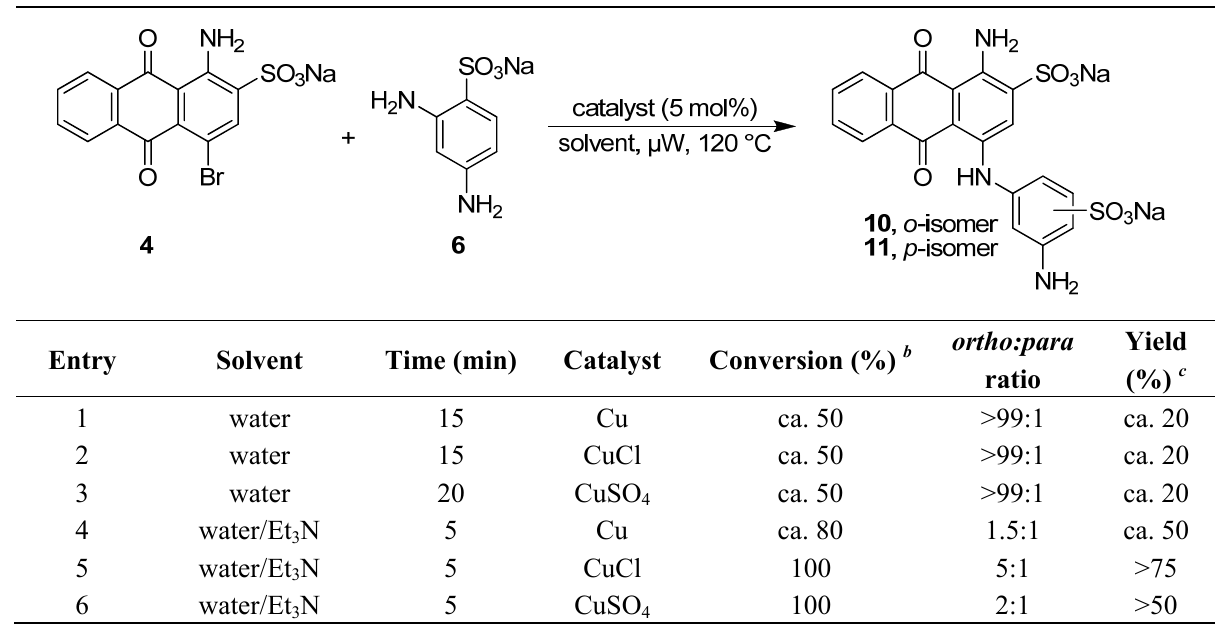
Table 5. Effects of different copper catalysts in the presence or absence of triethylamine (Et N) in water on the synthesis of compounds 8 and 9 . 3